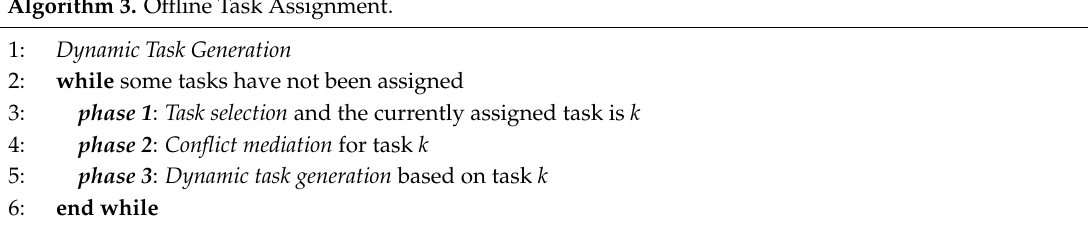
Algorithm 3. Offline Task